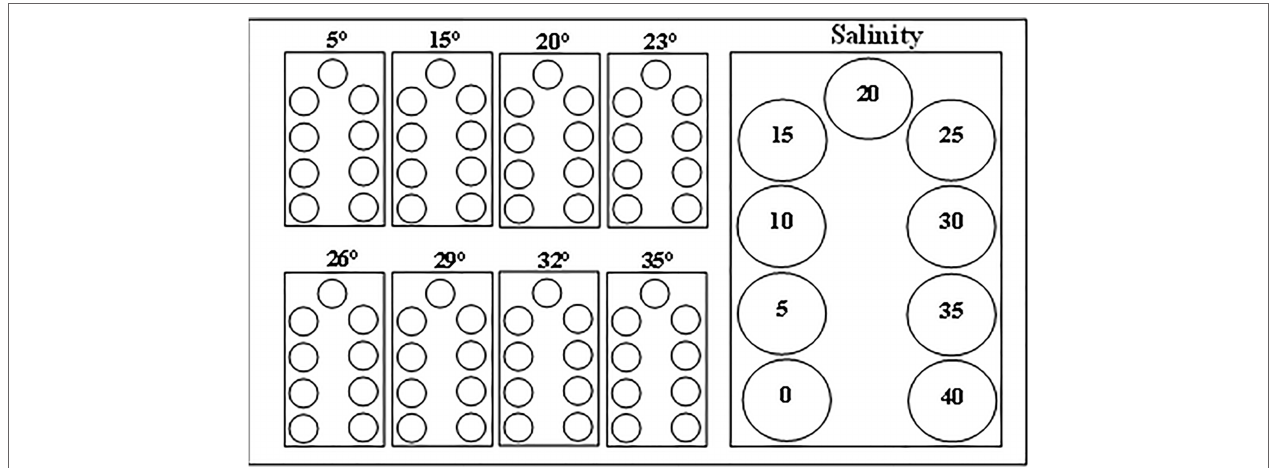
FIGURE 1 | Schematic representation of the experimental